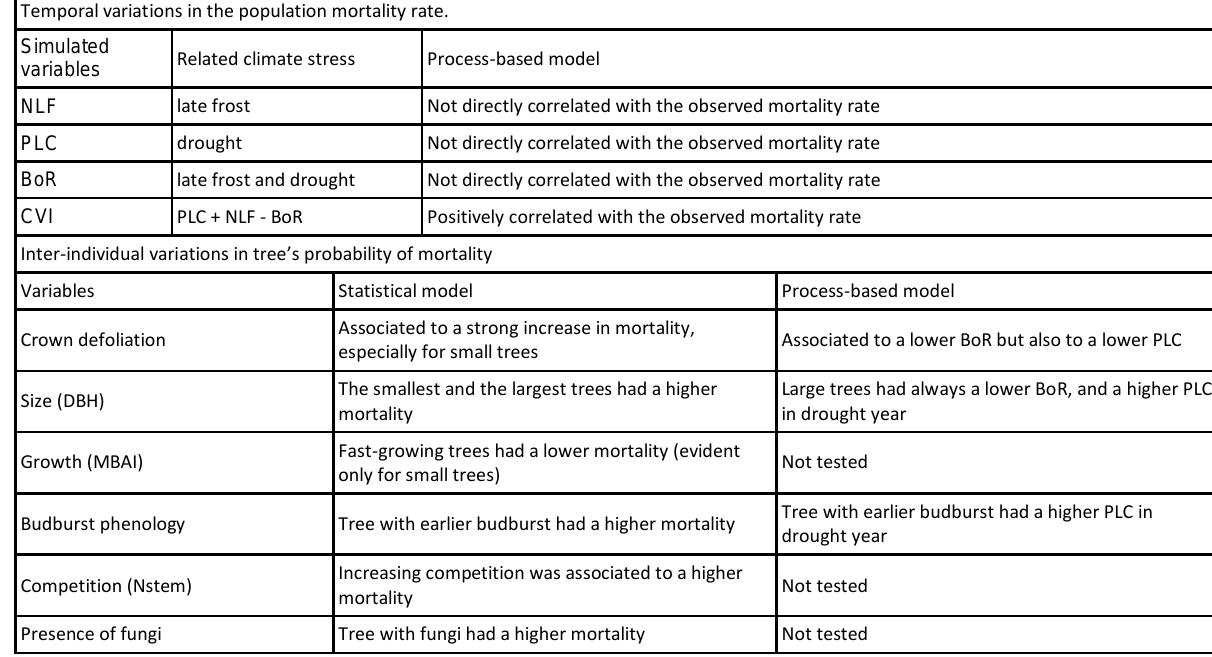
Table 3. Summary of the main effects of the studied variables on mortality. NLF: number of late frost days; PLC= percentage of loss conductance; BoR: Biomass of reserve Temporal variations in the population mortality